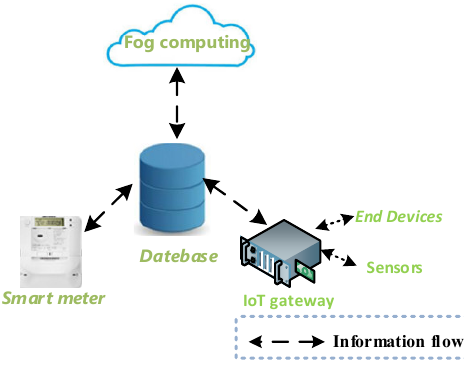
Figure 2 . Diagram of Internet of Things (IoT) devices connection and communication. Figure 2. Diagram of Internet of Things (IoT) devices connection and